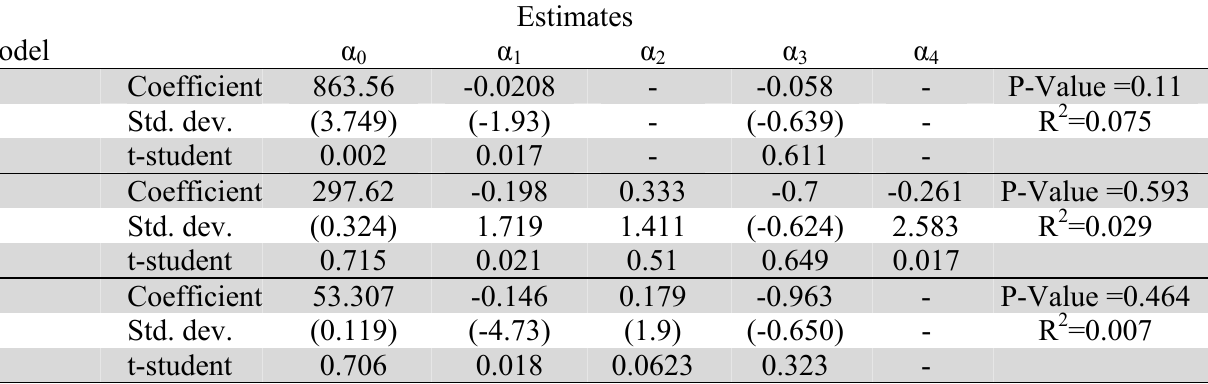
The results of t-student test for B & H and CAR Unequal Variances